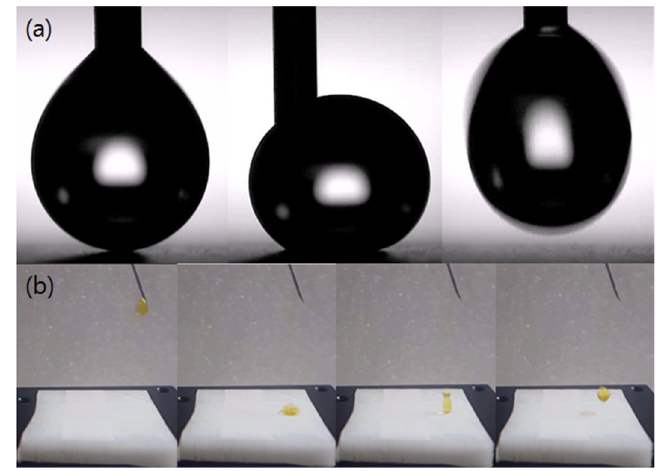
Figure 12. Demonstrations of the superhydrophobicity: ( a ) touching of an 8 μ L water droplet onto a coated sample with 20 μ m depth groove patterns; and ( b ) bouncing of a water droplet dropped from a 3 cm height.